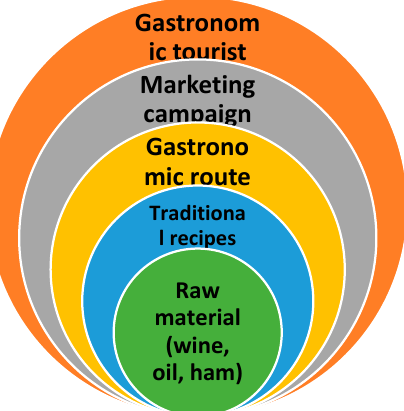
Figure 2. Pillars of gastronomic tourism in the province of Córdoba. Source: own elaboration.